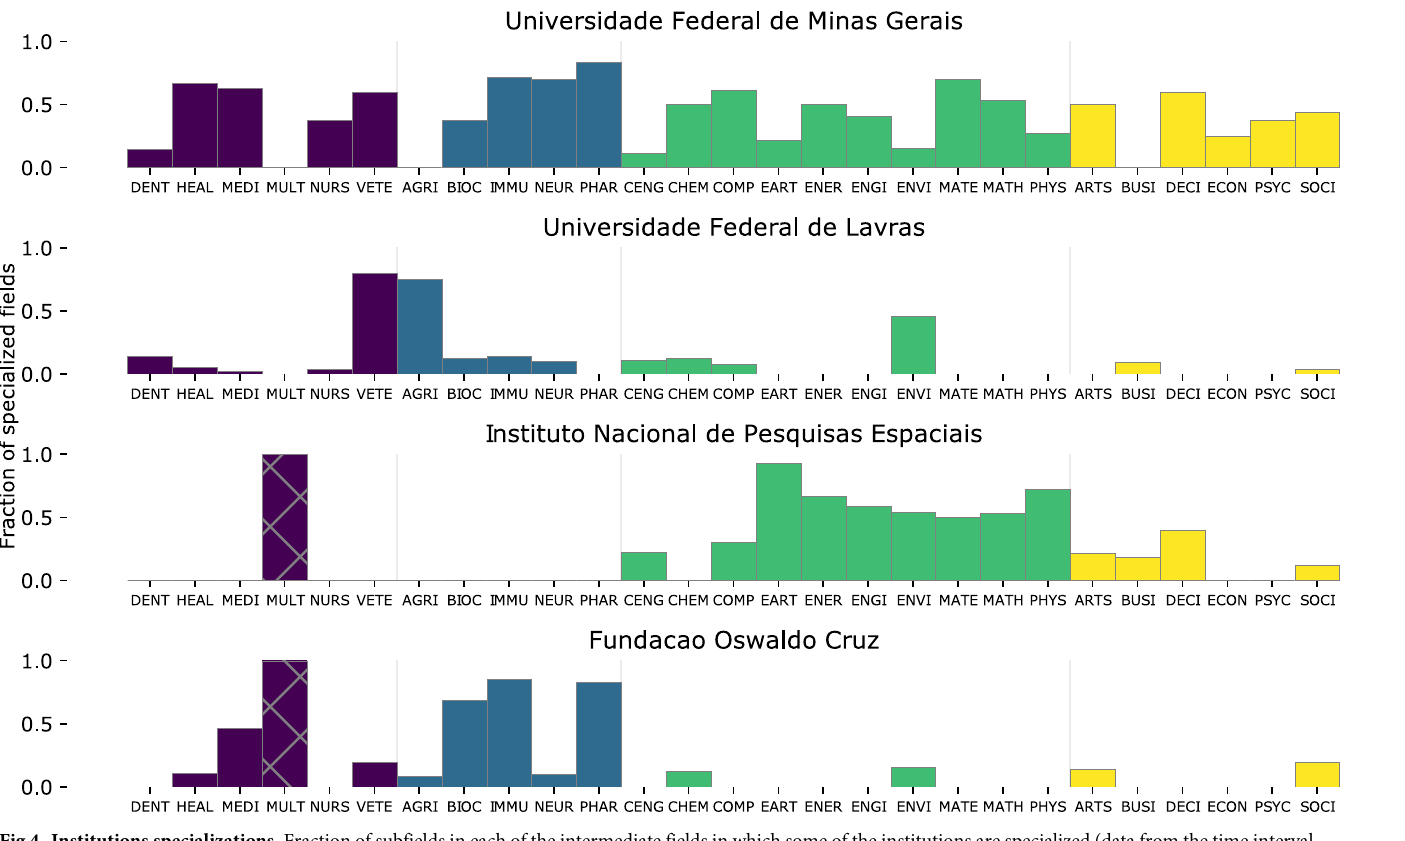
Fig 4. Institutions specializations. Fraction of subfields in each of the intermediate fields in which some of the institutions are specialized (data from the time interval [2000, 2014]). Intermediate classifications are grouped and colorcoded according to the macro field. The Multidisciplinary (MULT) intermediate field has only a single subfield and is then shown with